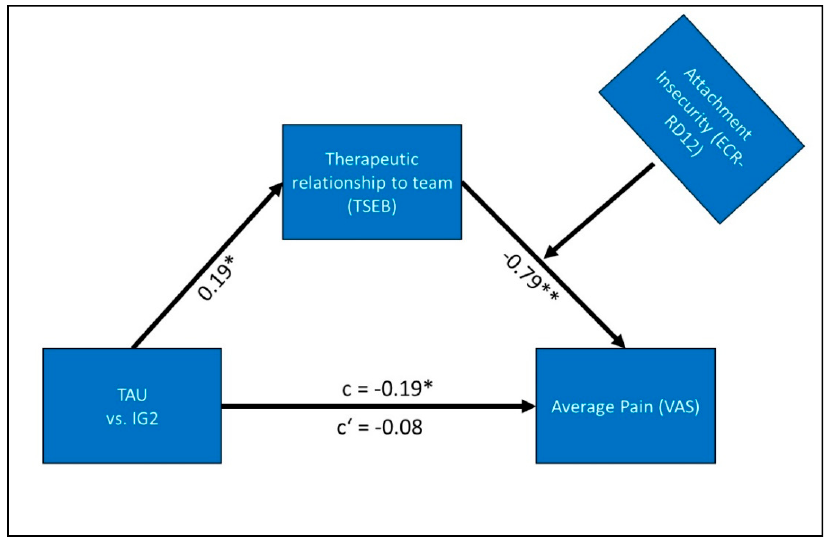
Figure 5. Summary of results for moderated mediation analysis. Note: p < 0.05 = *, p < 0.01 = **, c = direct effect before mediation, c‘ = direct effect after mediation.